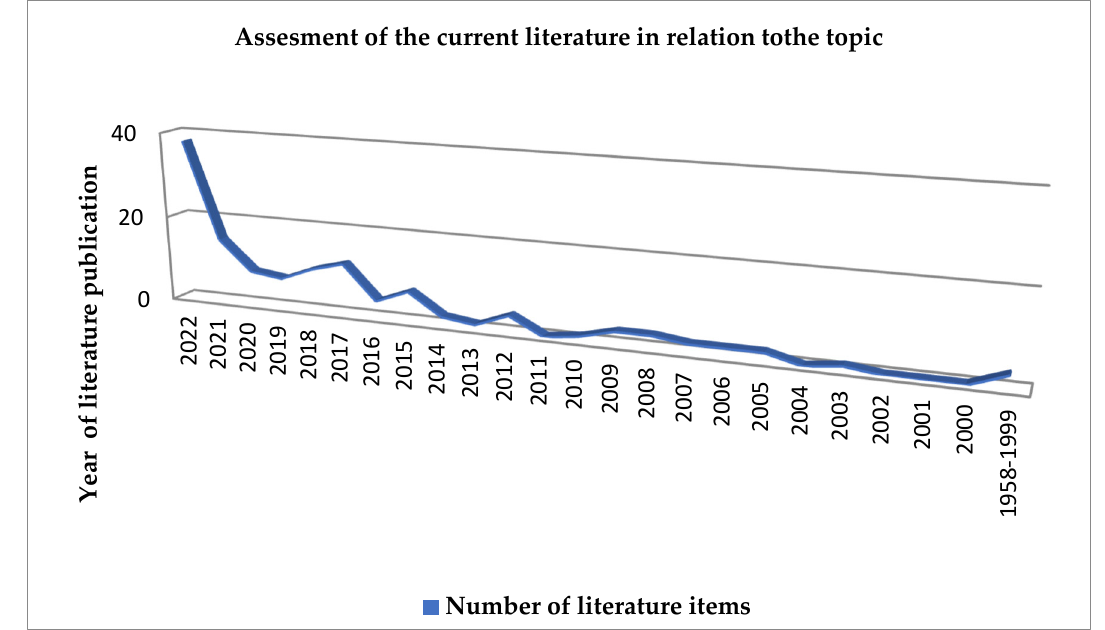
Figure 2. Evaluation of the timeliness of the literature in relation to the thematic thread explored.